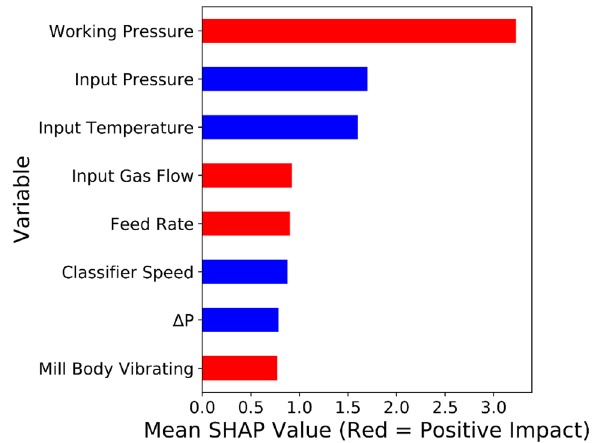
Figure 4. Ranking SHAP values and magnitude of relationships between VRM monitoring variables and output temperature.